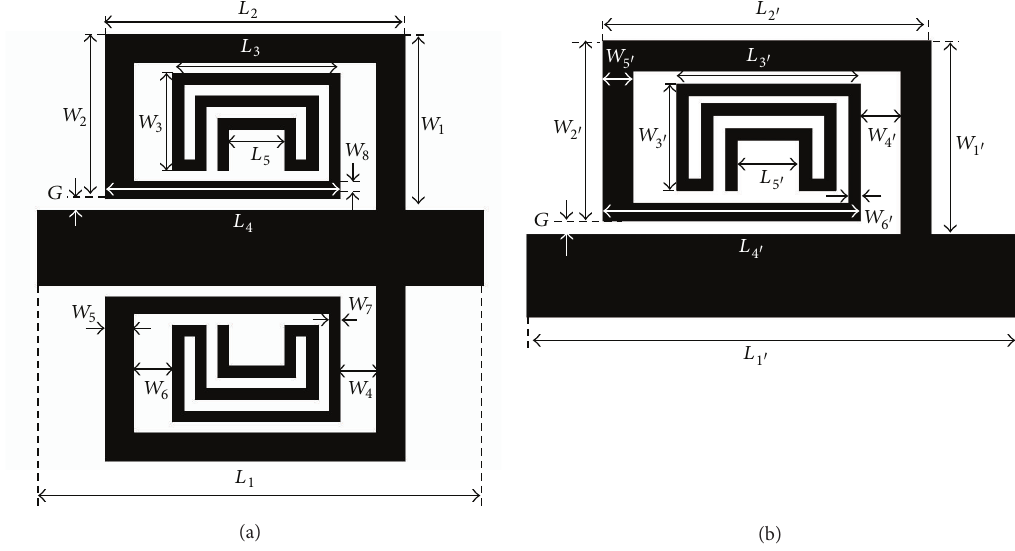
Figure 1: Design layouts of the two proposed TBBSFs: (a) symmetric, (b)